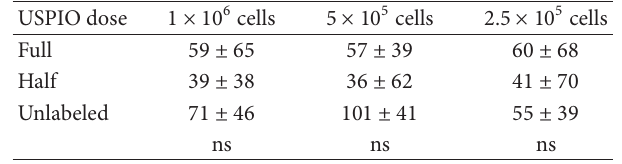
Table 5: MRI intensity differences after 2-hour USPIO